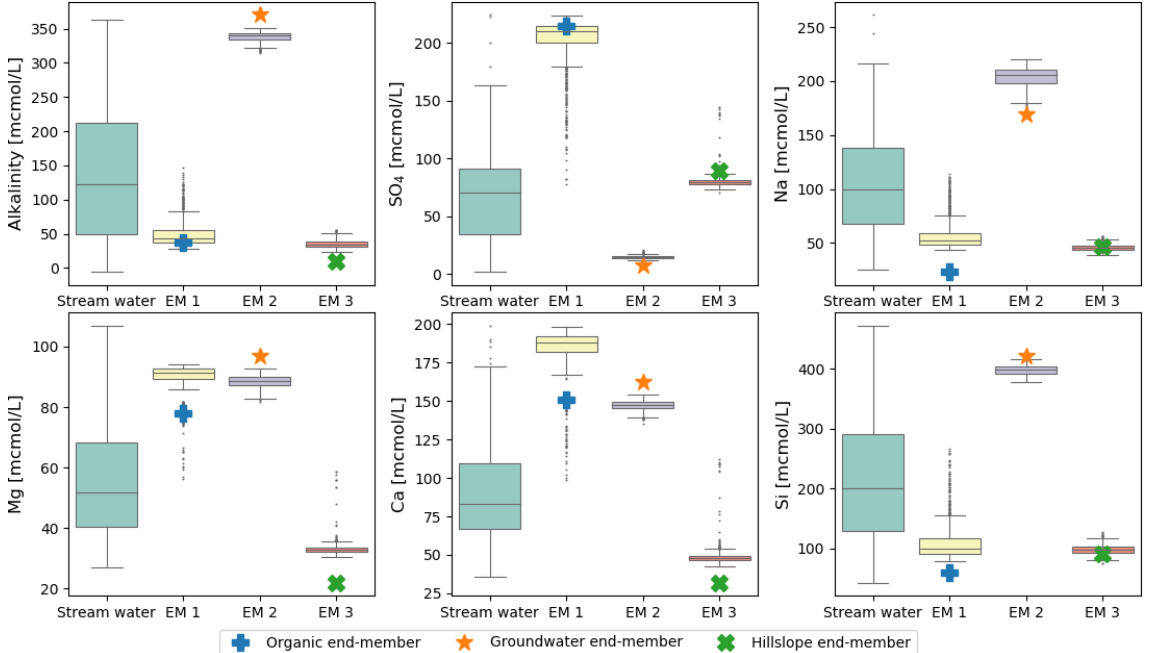
Figure 5. Uncertainties of CHEMMA-predicted end-members (EM 1 to EM 3) compared with the total solute variances (stream water). The four columns represent the stream water samples and three CHEMMA-identified end-members. Each CHEMMA end-member (EM 1 to EM 3, predicted without using the field end-member samples) is matched with a field-measured end-member, based on the similarity of the concentration profile. The six subplots represents six stream water solute